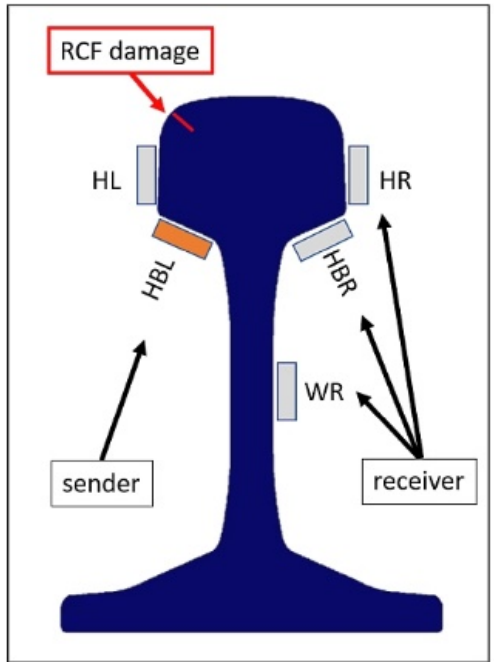
Figure 3. Sketch illustrating the positions of SAW sender and receiver with respect to the rail damage location. Explanations of the abbreviations are given in the text.